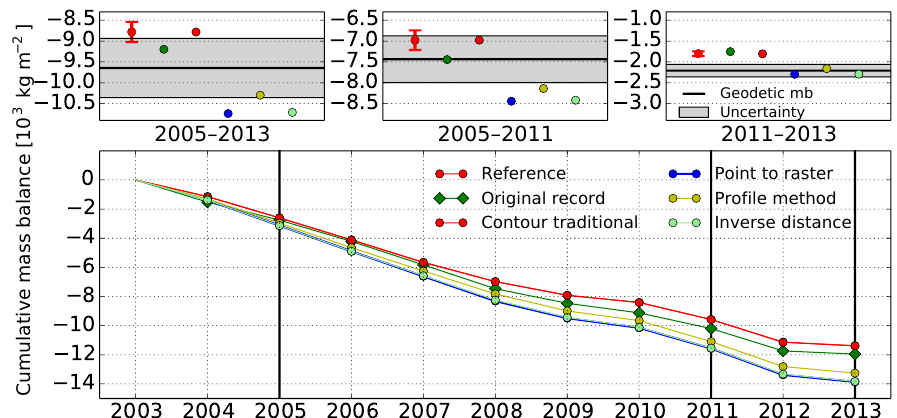
Figure 10. Comparison between geodetic and glaciological mass balances for three periods (upper three subplots) and cumulative series of annual mass balance calculated using the set of extrapolation methods described in the